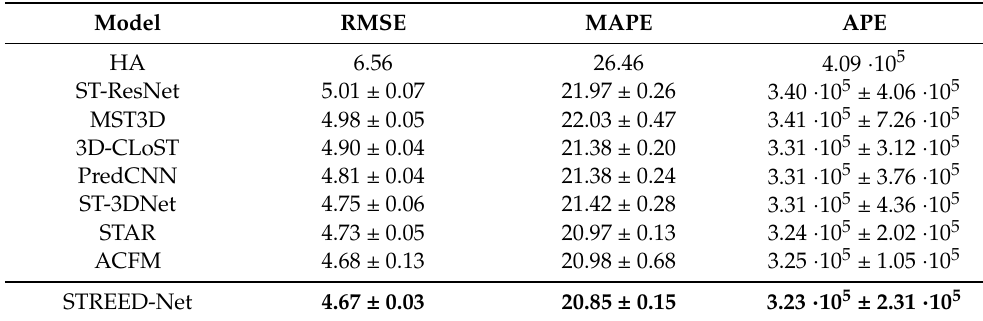
Table 1. Results obtained for the Bike NYC data set.